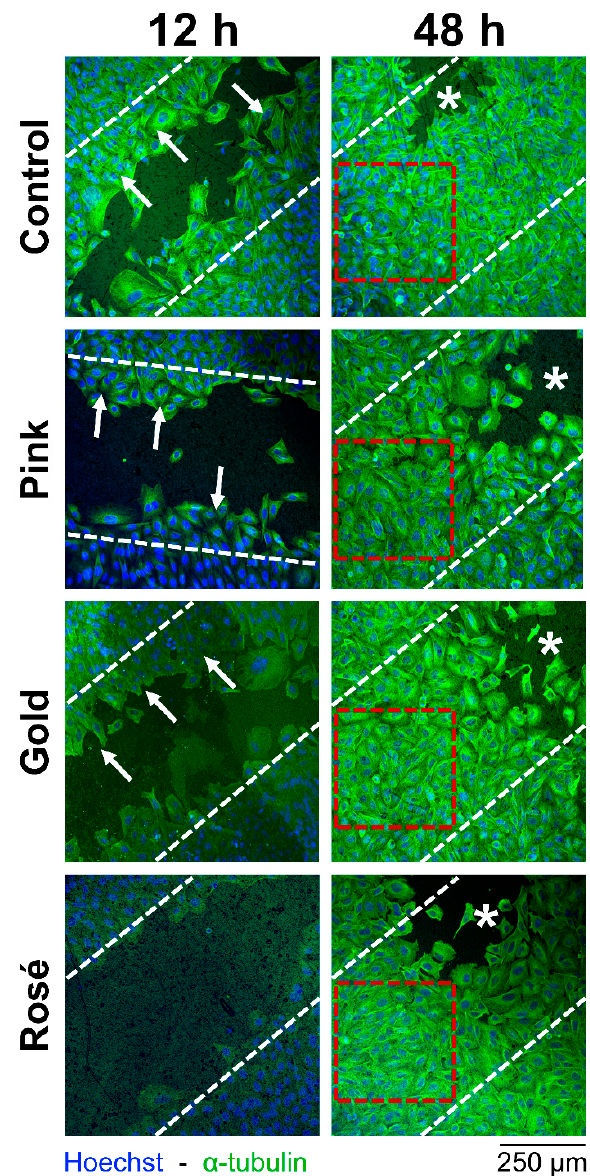
Figure 2. Representative cell migration assay images at 12 and 48 h, showing the different groups. Smaller cell-free areas in images indicates better migration of cells. White dashed lines indicate the 500- µ m cell-free area which existed after the removal of the silicon insert. Arrows identify Saos-2 migrating cells on the cell-free area during the initial repopulation of the cell-free area at 12 h. Red dashed squares designate full repopulation of the cell-free area at 48 h. Asterisks indicate areas for which the gap was originally larger than 500 µ m (excluded from the recordings). Images at baseline, 24 h and 40 h omitted for clarity.